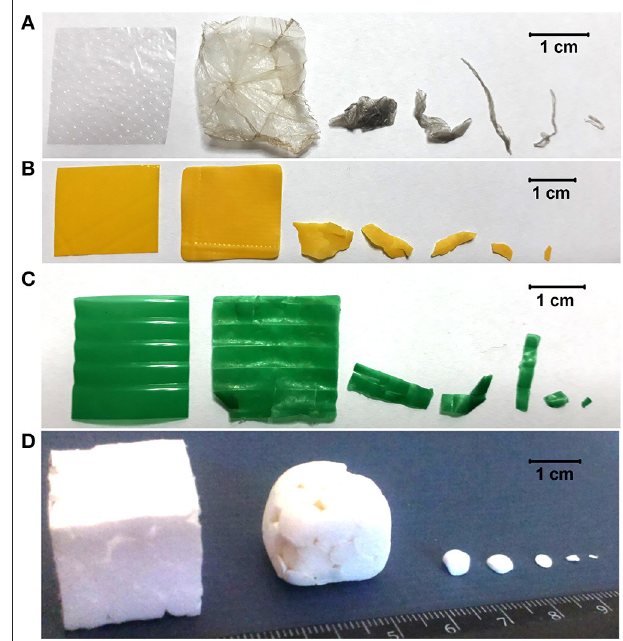
FIGURE 2 | Large plastic items (LPIs, 2cm each side) of LDPE (A) , PP (C) , and PS in its solid (B) and foamed (D) form, and examples of macro- and microplastic items present after 24h of mixing with pebbles and